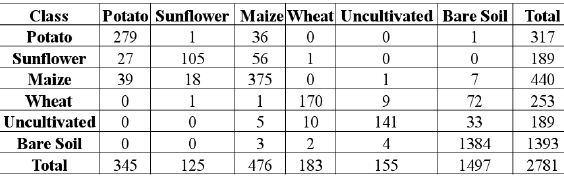
Table 1. Maximum Likelihood classification confusion matrix